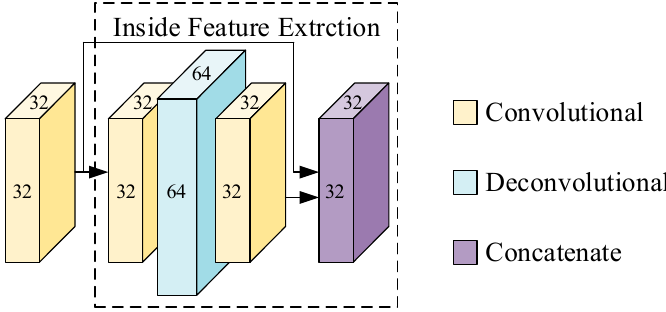
Figure 3. Inside feature extraction (IFE) process. The feature map will be enlarged first (32 × 32 to 64 × 64) and then reduced (64 × 64 to 32 × 32).